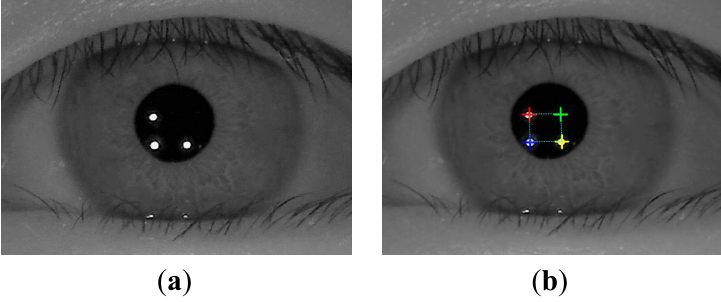
Figure 9. Example of estimating the unseen SR positions based on the parallelogram shape that is defined by the existing three SR positions ( a ) Original image (magnified eye region) of Figure 5b including three corneal SR regions; ( b ) Resulting image including four corneal SR regions (the upper-right corneal SR is estimated based on the parallelogram shape defined by the three existing SR positions).